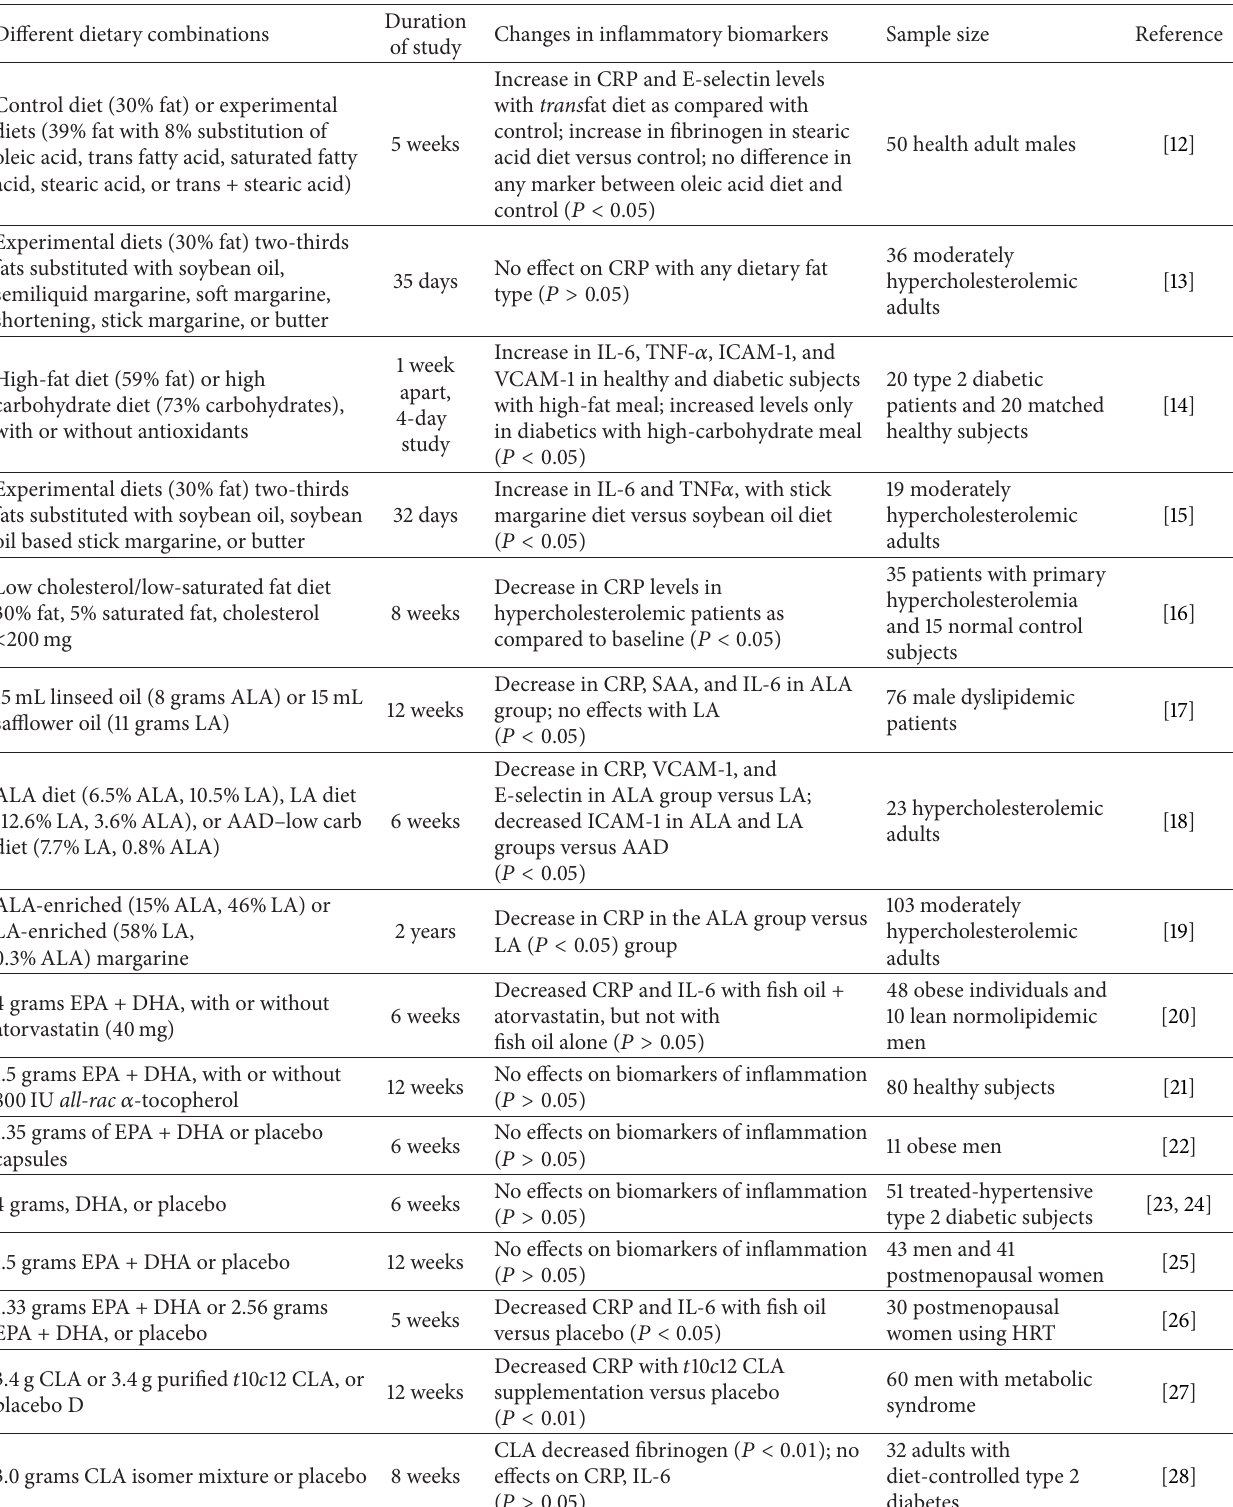
Table 2: Summary of supplementation studies examining the effects of dietary interventions with different fatty acids on biomarkers of